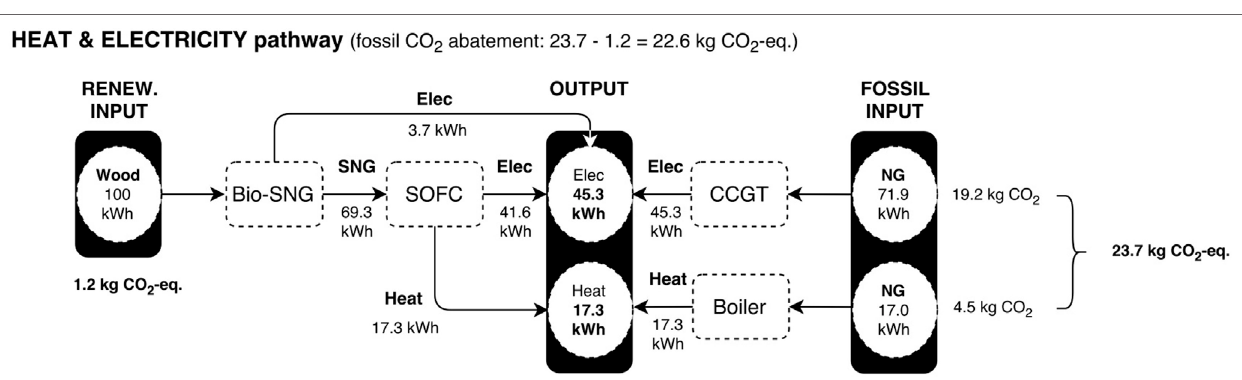
FigUre 5 | Substitution pathway example for the heat and electricity approach.